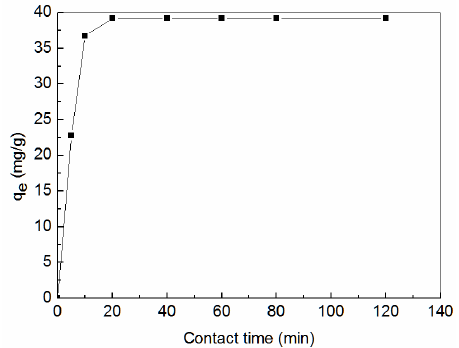
Figure 7. Effect of contact time on equilibrium adsorption capacity ( q e ).